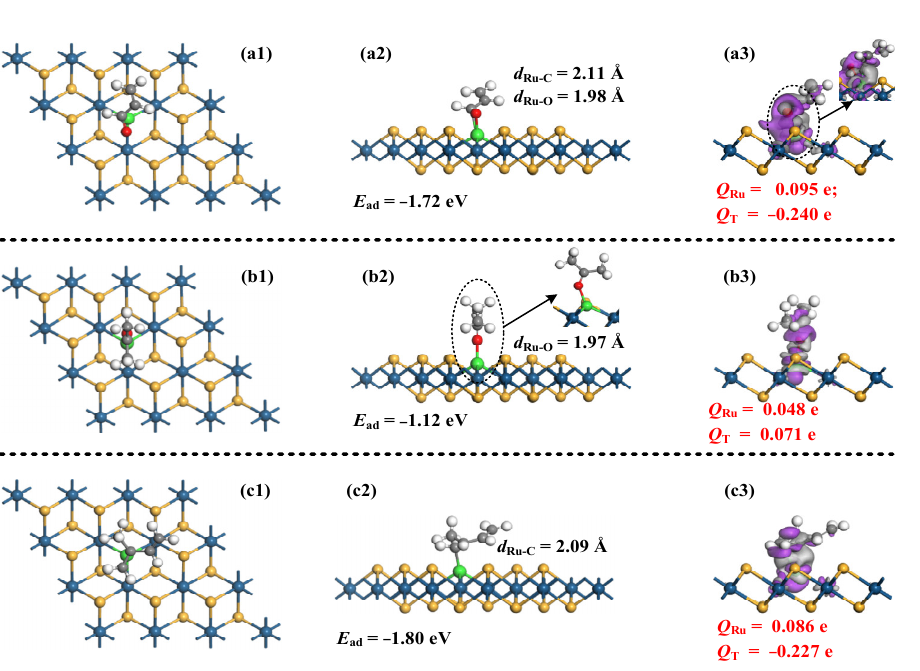
Figure 4. MSC and CDD of C 3 H 4 O system ( a1 – a3 ), C 3 H 4 O system ( b1 – b3 ) and C 5 H 8 system ( c1 – c3 ). In CDD, the set is the same as in Figure 1.